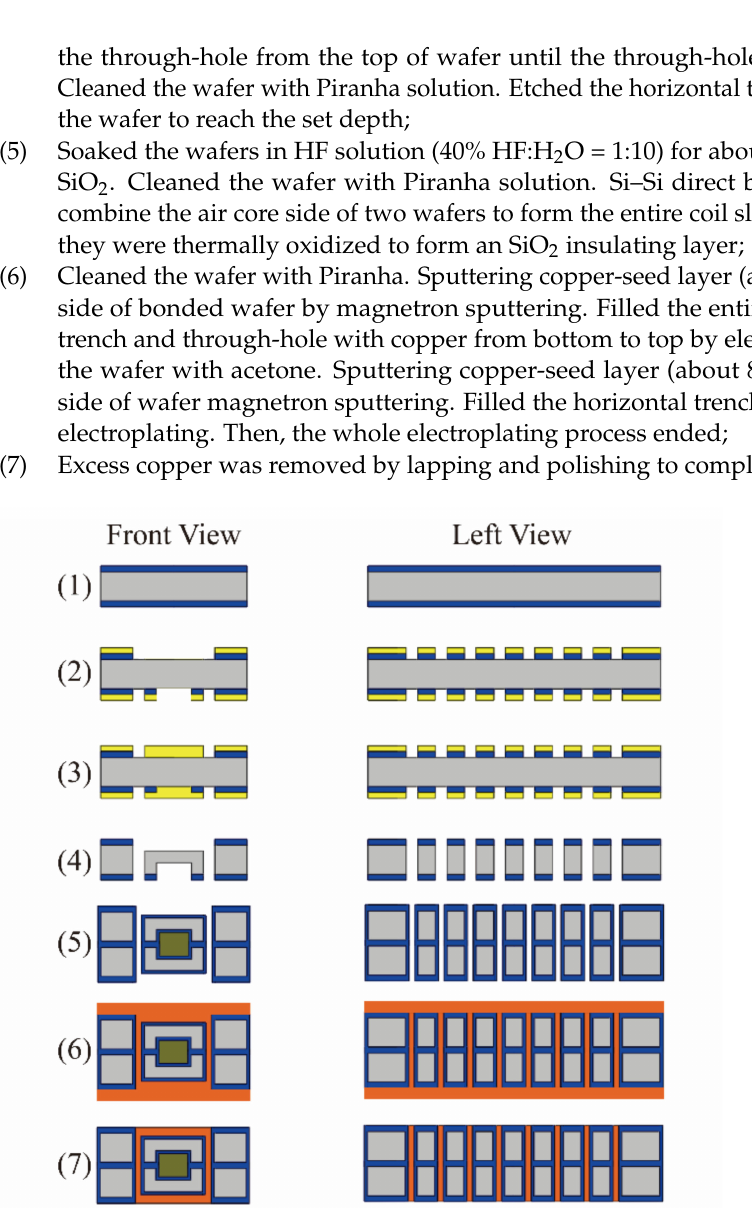
Figure 7. Brief processing flow of in-chip transformer. (1)–(7) respectively correspond to the 7 steps in the